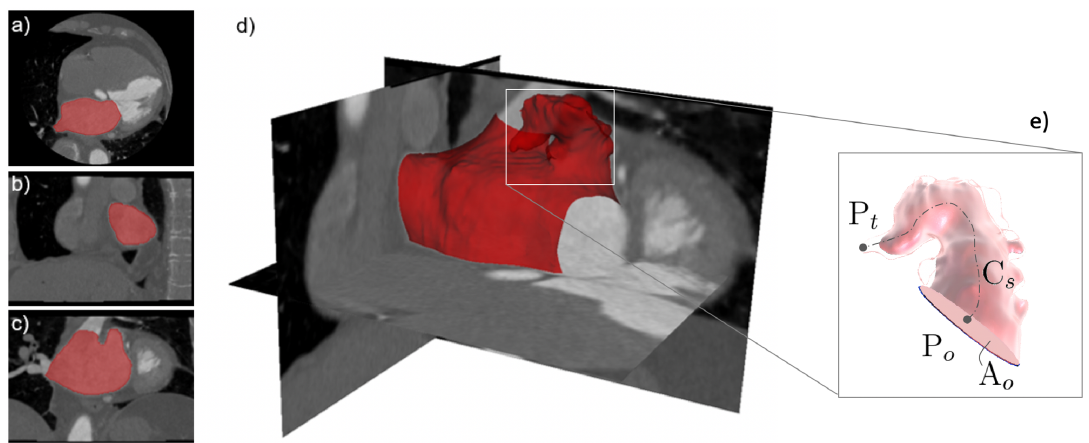
Figure 1. Example of volumetric CT segmentation with axial ( a ), sagittal ( b ) and coronal ( c ) planes and resulted 3D model ( d ). Identification of the area of the ostium ( A o ) and of the centerline C ( s ) from P o , where P t ( e ).